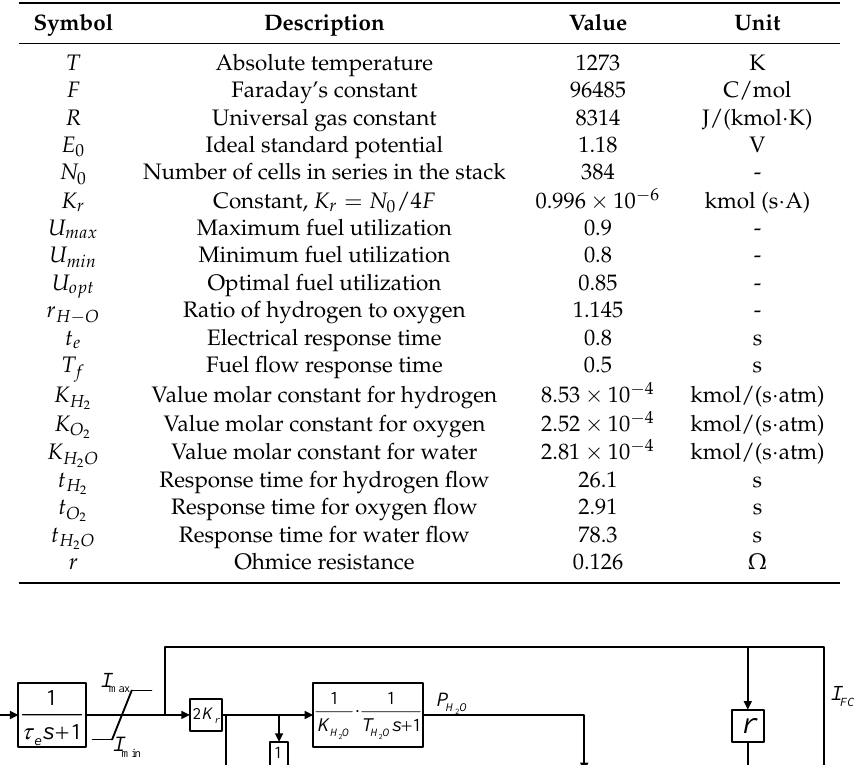
Table 2. FC model parameters used for simulation.